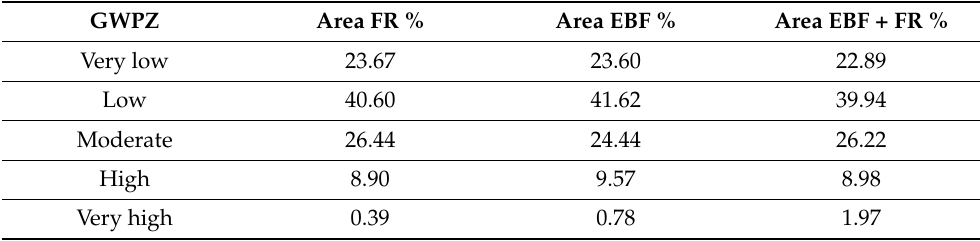
Figure 7. GWPZs: ( a ) Fr model; ( b ) EBF model; ( c ) FR–EBF model; ( d – f ) subsets of Sentinel-2 (2022). Table 3. GWPZ areas.